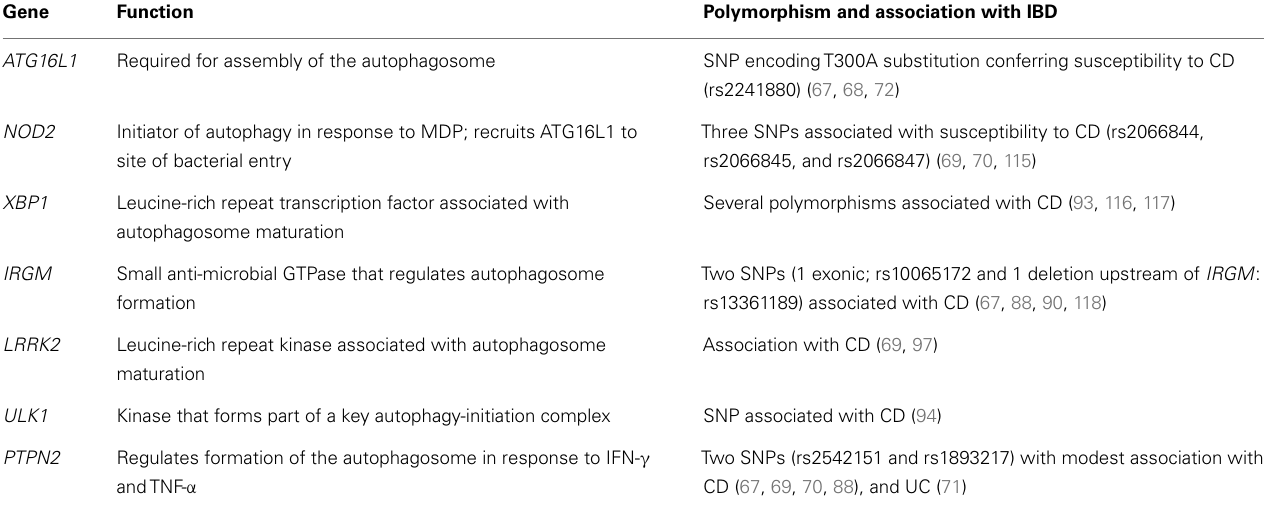
Table 1 | Genetics of aberrant autophagy in